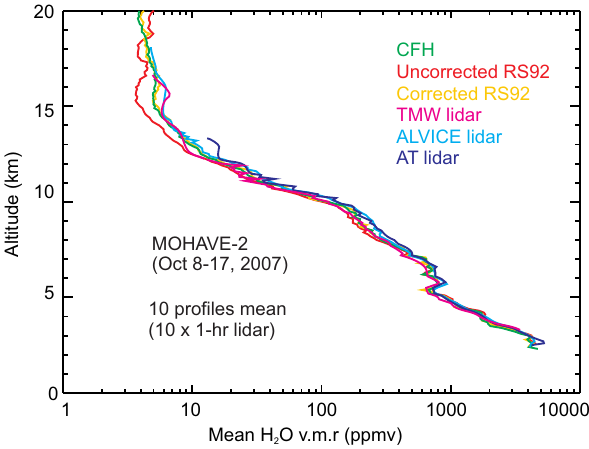
Fig. 10. Averaged water vapor mixing ratio computed from 10 pro- files measured simultaneously during MOHAVE-II by the TMW lidar, two other lidars, CFH, and Vaisala RS92 radiosondes.